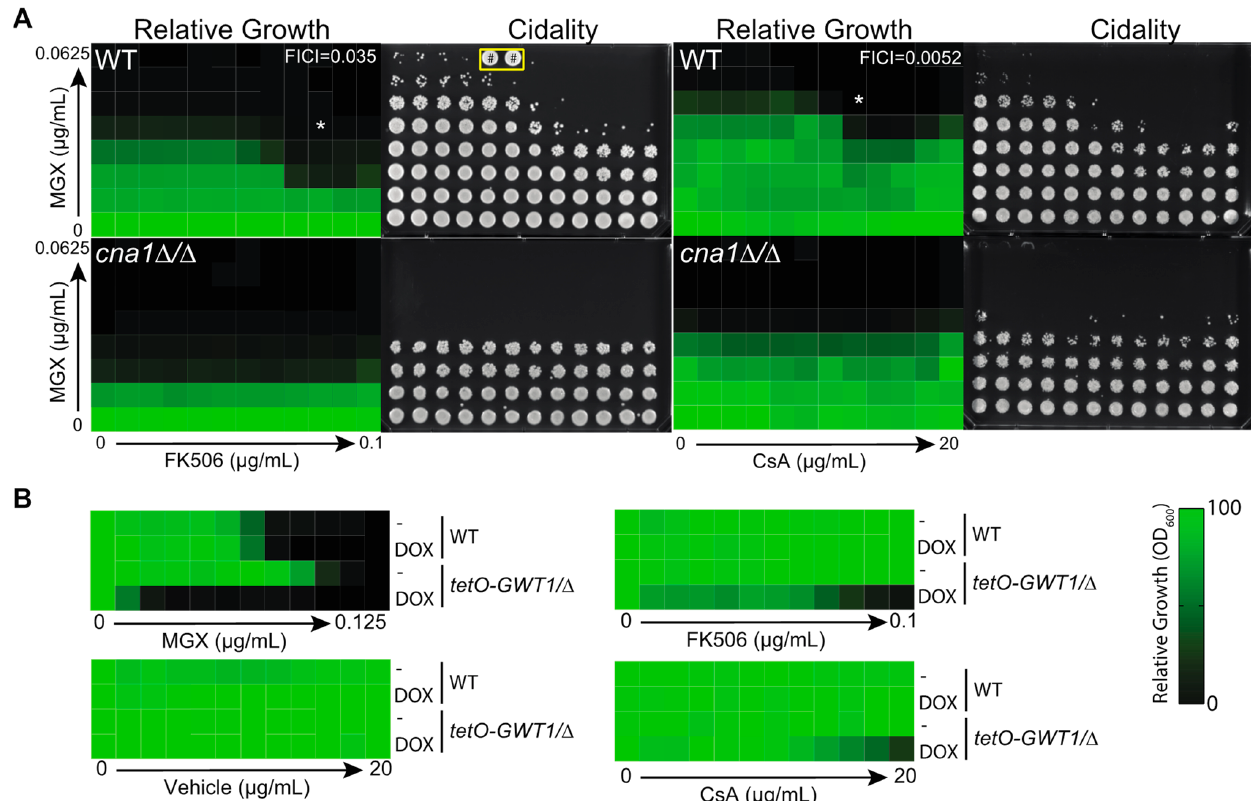
Figure 2. Calcineurin and Gwt1 are responsible for synergistic interaction between MGX and FK506 or CsA. ( A ) Dose-response matrices were generated for MGX and FK506 or MGX and Cyclosporin A against wild-type C. albicans and a cna1 Δ / Δ mutant derivative. Growth was monitored by OD 600 after 24 h incubation in YPD medium and normalized to vehicle control wells. Data are mean relative growth for triplicate wells from a representative experiment. This experiment was performed in two additional replicates with similar results. To assess viability after combination treatments, cells were transferred onto drug-free YPD agar and photographed after 48 h growth. Contaminated wells are marked with a pound sign and surrounded with a yellow box. The lowest FICI value is inset (white text), and the corresponding well indicated with an asterisk. ( B ) Transcriptional repression of GWT1 sensitizes C. albicans to FK506 and CsA. Dose response assays were performed with C. albicans or tetO-GWT1/ Δ mutant derivative in the presence or absence of DOX. Growth was monitored by OD 600 after 24 h incubation and normalized to vehicle control wells. Data are mean relative growth for three replicate wells from a representative experiment. This experiment was performed in two additional replicates with similar results.